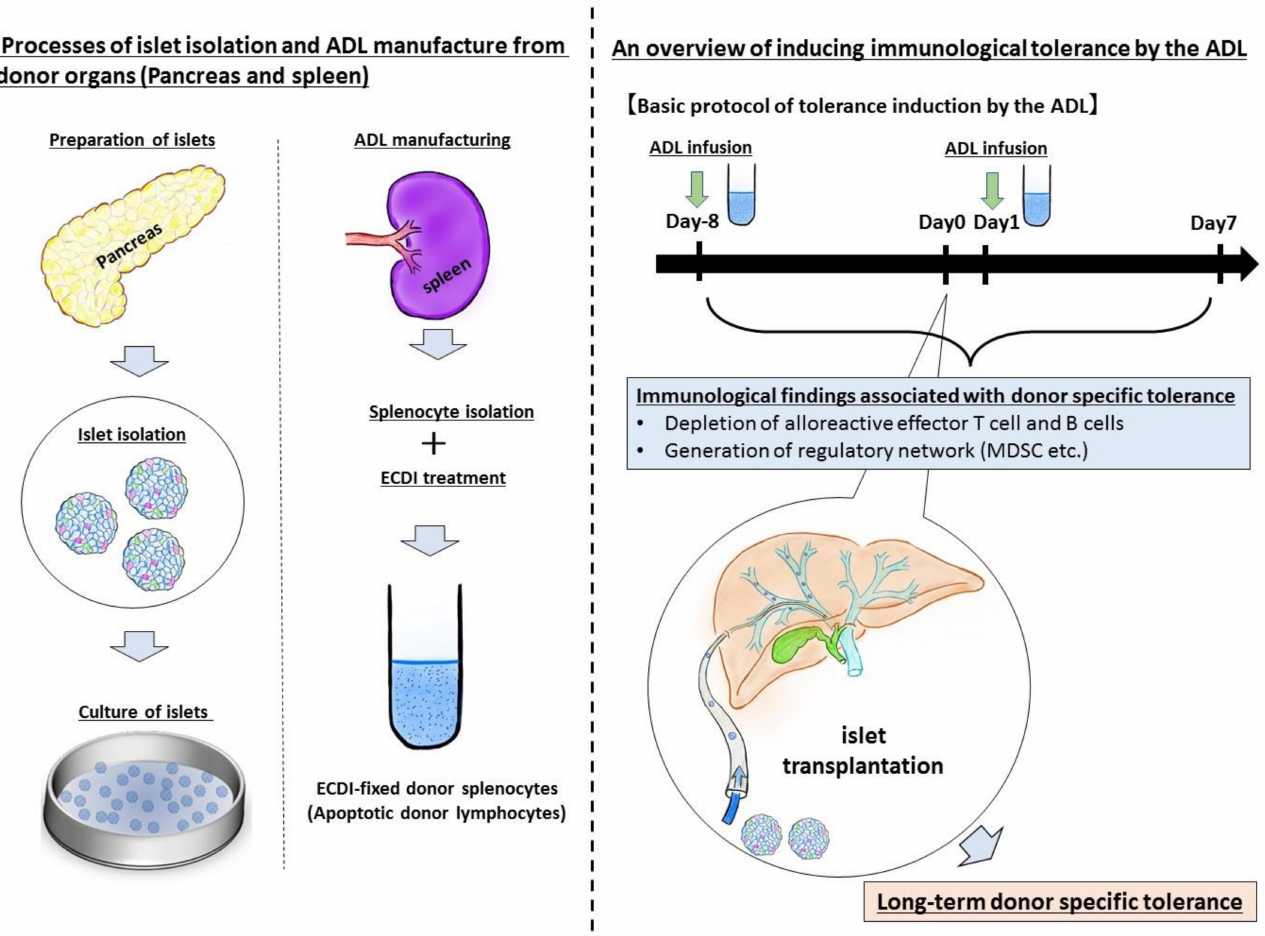
Figure A1. A schema describing an overview of donor-specific tolerance induction by the ADL